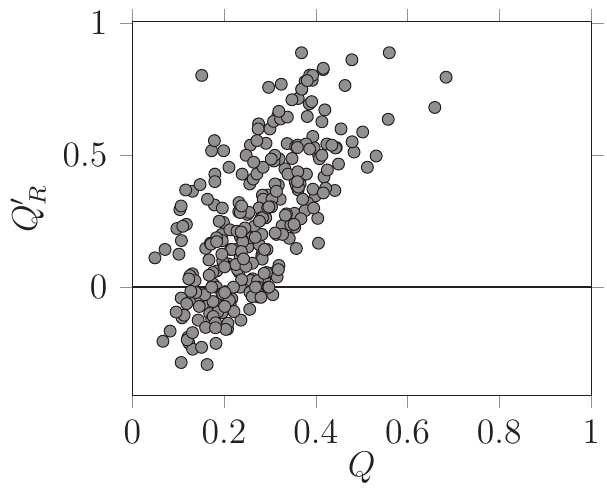
Figure 2. Relationship between the modularity of the best partition using the Louvain method and the a posteriori realized modularity. There exists a strong, positive relationship between the two variables. Worth noting is the fact that, for some networks, the best partition resulted in negative versions of Q ′ were more interactions between than within modules. Each dot corresponds to a network .